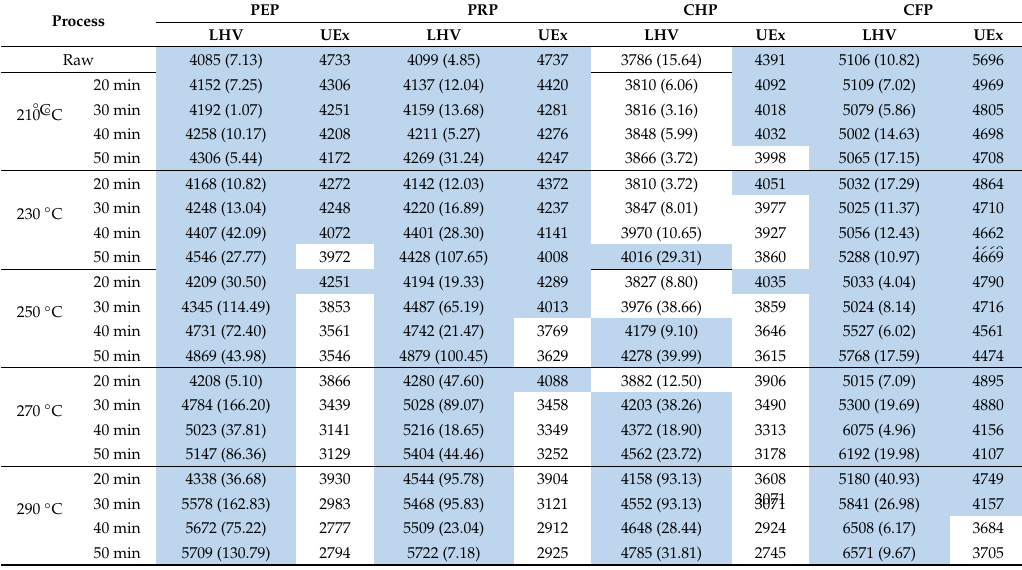
Table 3. The lower heating value (LHV) and useful exergy of each